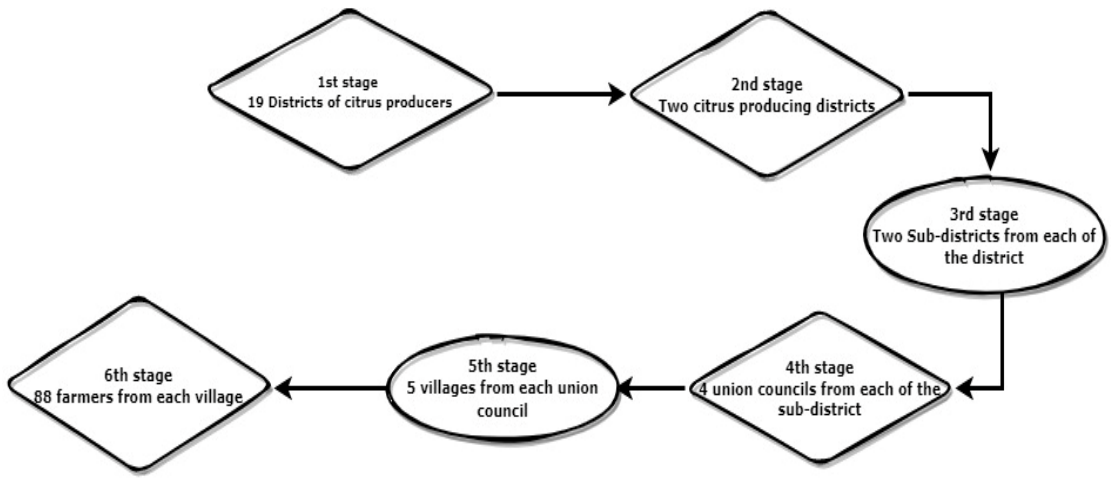
Figure 1. Study area.